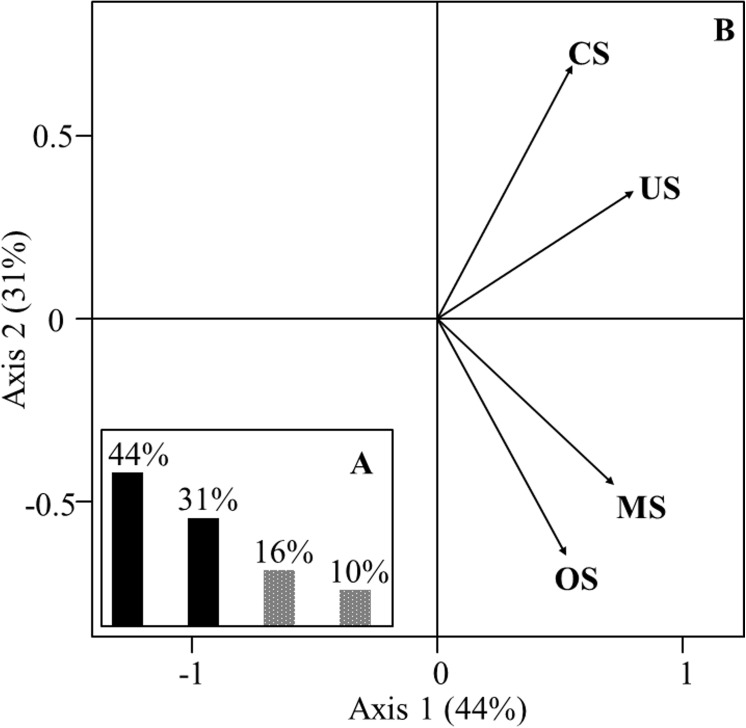
Interstructure plots to study spatial variability of environment-fishing variables and species assemblage on bathymetric strata.(A) Eigenvalues histogram of vector covariance matrix. (B) Projection tables (bathymetric strata) on the first factor plane of the compromise. Four tables pairs as bathymetric strata: coastal shelf (CS), upper shelf (US), mid-shelf (MS) and outer shelf (OS).